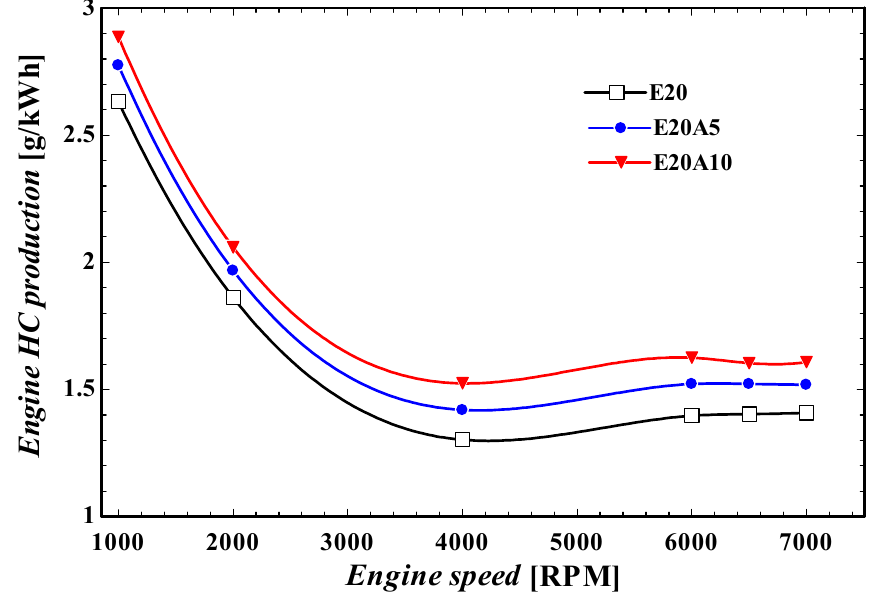
the port injection of ammonia increased up to 5% and 10%, the HC emission increased by 6% and 10%, respectively. However, the increase in HC and CO emissions caused by the in vehicles [37–39].